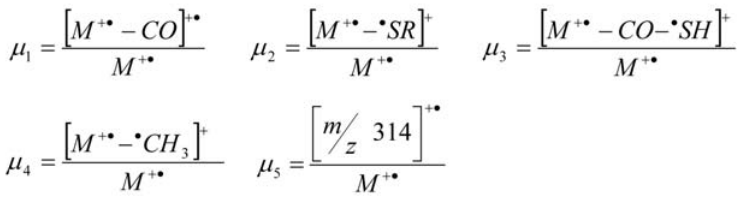
Elemental composition